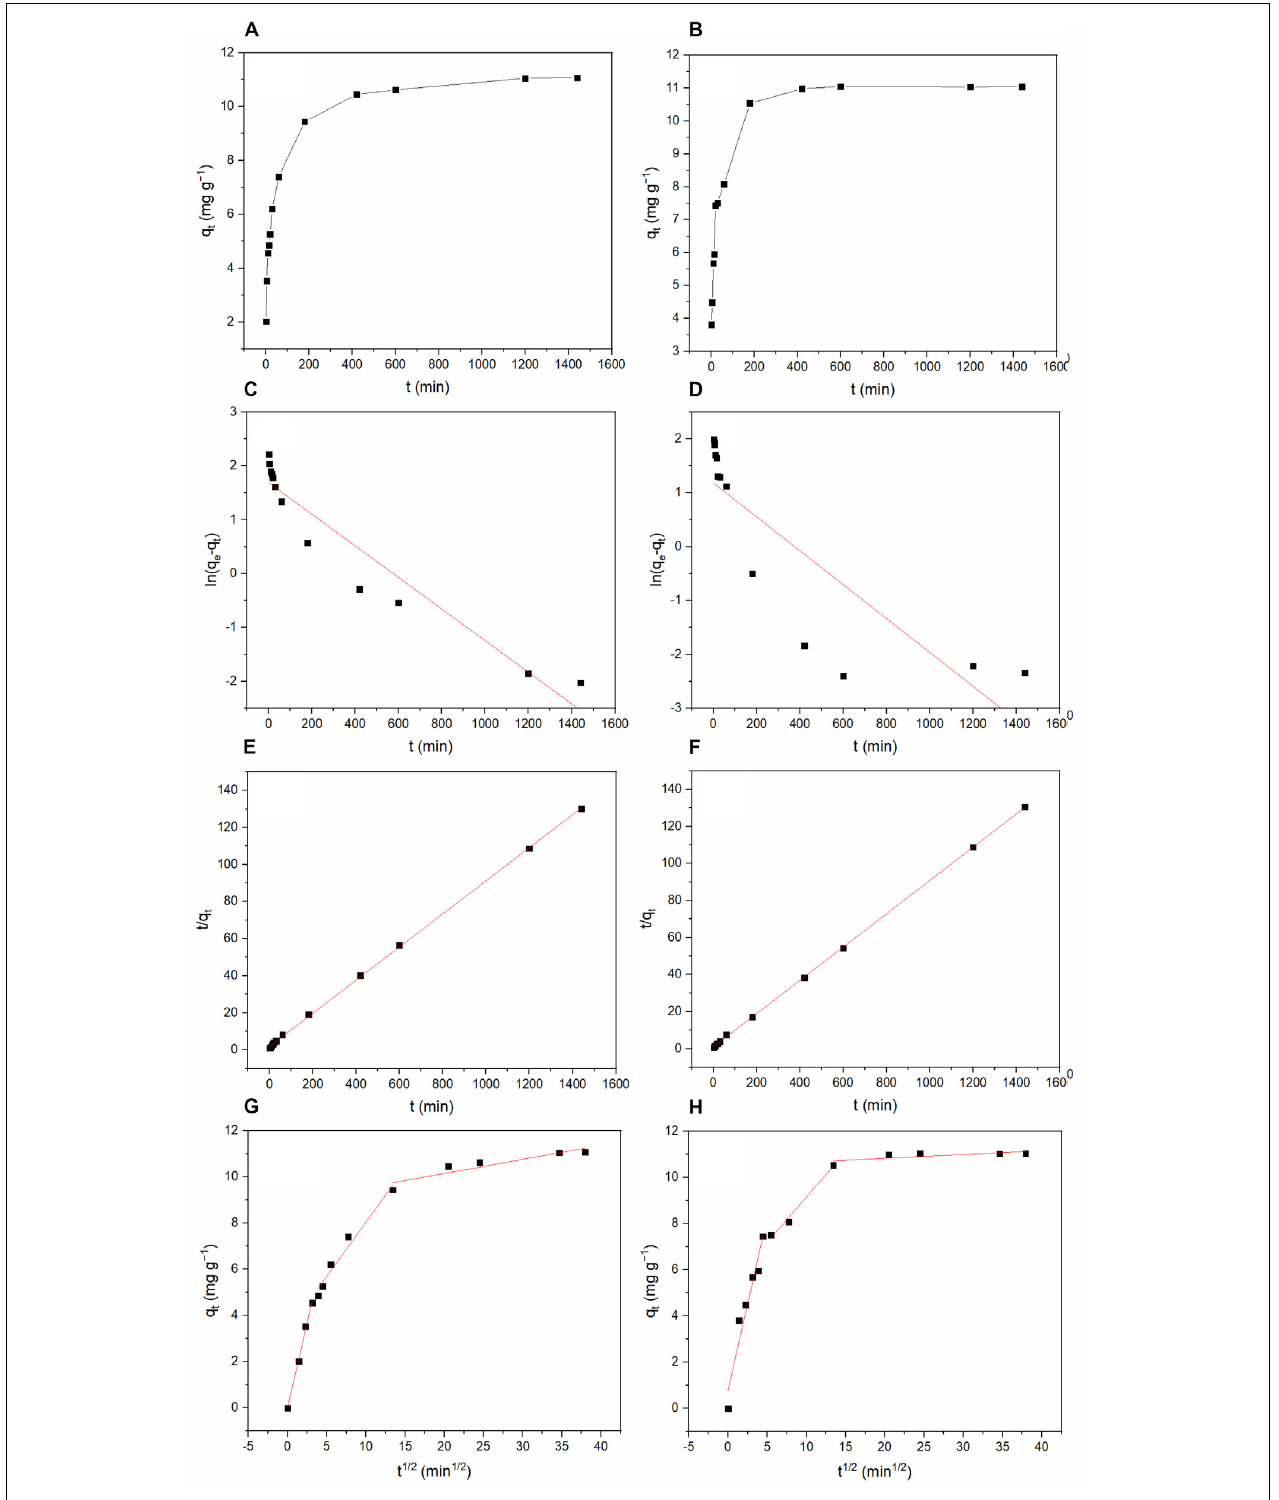
FIGURE 10 | Kinetics of the adsorption process of TC and DC by BC/MnO 2 : (A) Change in TC adsorption amount with time; (B) Change in DC adsorption amount with time; (C) TC adsorption modeled using the pseudo-first-order equation; (D) DC adsorption modeled using the pseudo-first-order equation; (E) TC adsorption modeled using the pseudo-second-order equation; (F) DC adsorption modeled using the pseudo-second-order equation; (G) TC adsorption modeled using Intraparticle diffusion equation; and (H) DC adsorption modeled using Intraparticle diffusion equation.